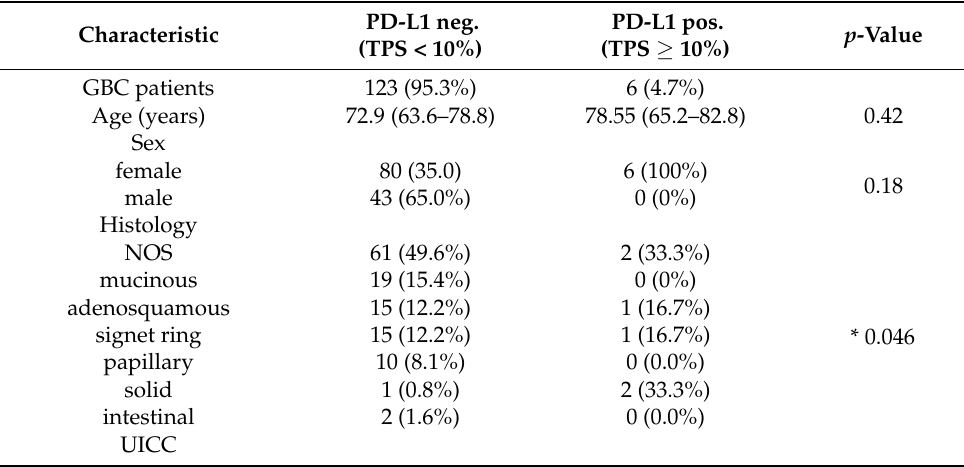
Table 2. Clinicopathological characteristics (at 10% TPS